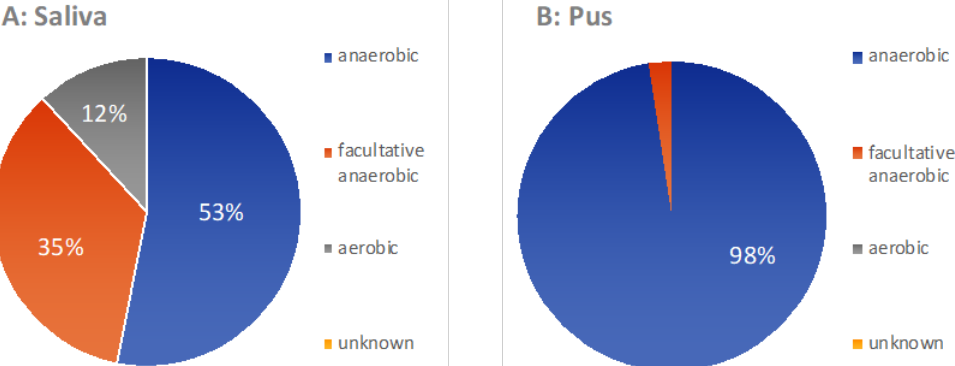
Figure 9. Principal component analysis biplot of all saliva and pus samples ( n = 100; sum of rows > 20%) in order to visualize the relationship between the bacterial genera and the distances between samples (beta diversity). As can be seen, there is almost a complete separation of the samples (saliva and pus).